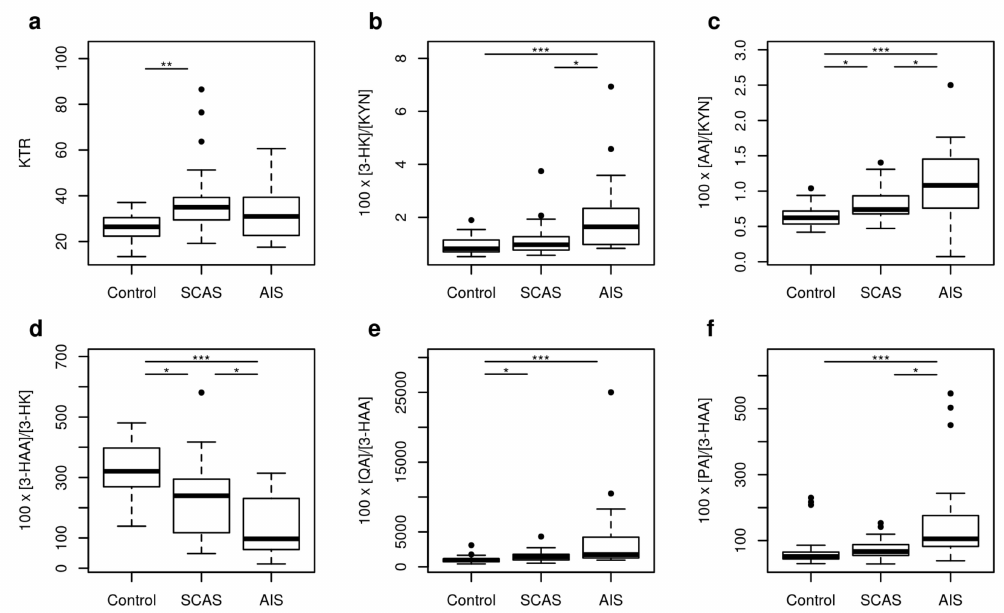
Figure 3. The boxplots of enzyme activities changed in neurovascular disease. ( a ) KTR: IDO activity defined as 1000 × [KYN] / [TRP]; ( b ) 100 × [3-HK] / [KYN]: KMO activity; ( c ) 100 × [AA] / [KYN]: KYNU A activity; ( d ) 100 × [3-HAA] / [3-HK]: KYNU B activity; ( e ) 100 × [QA] / [3-HAA]: 3-HAO activity; ( f ) 100 × [PA] / [3-HAA]: the composed 3-HAO and ACMSD activity. Significance codes for post-hoc Dunn test: *** p < 0.001, ** p < 0.01, * p < 0.05.